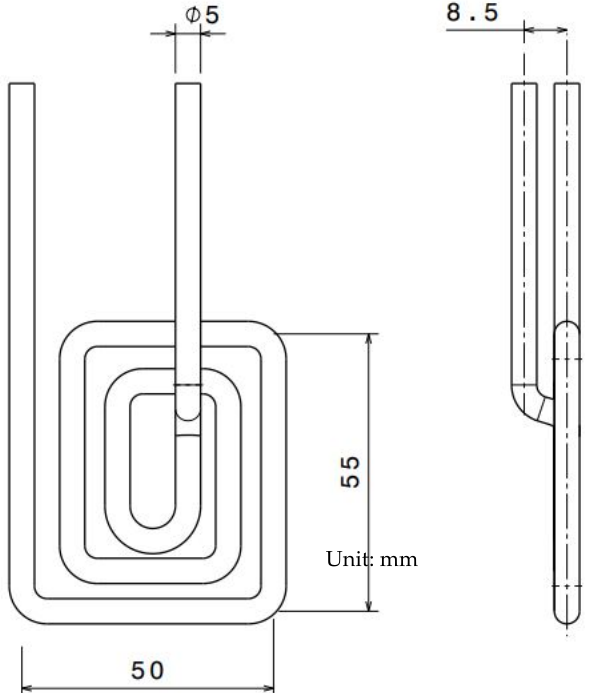
Figure 7. Induction coil’s geometry and dimensions.